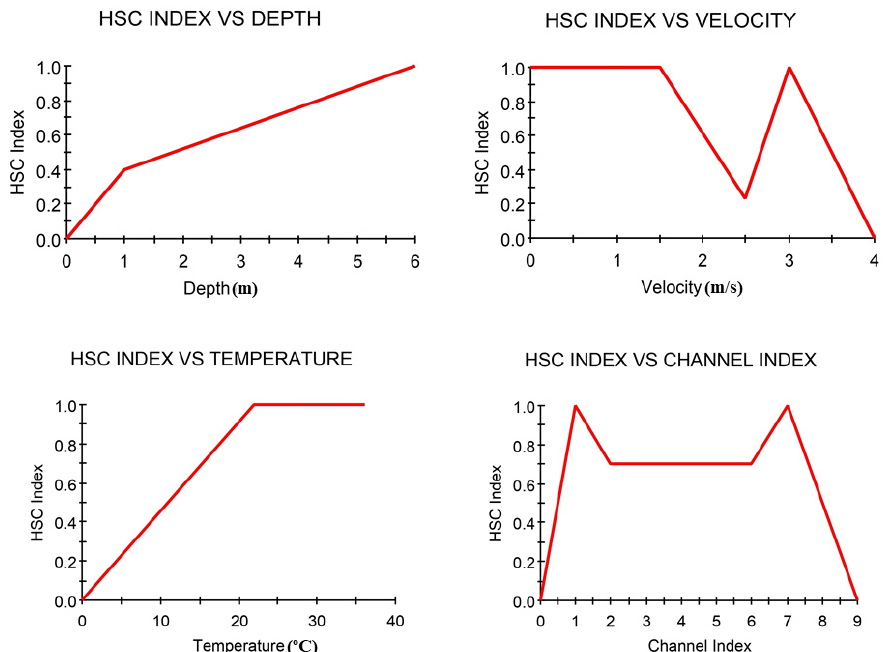
Figure 6. Habitat suitability indices for the different adult stages of Labeo rohita (Rohu fish) (after [34].